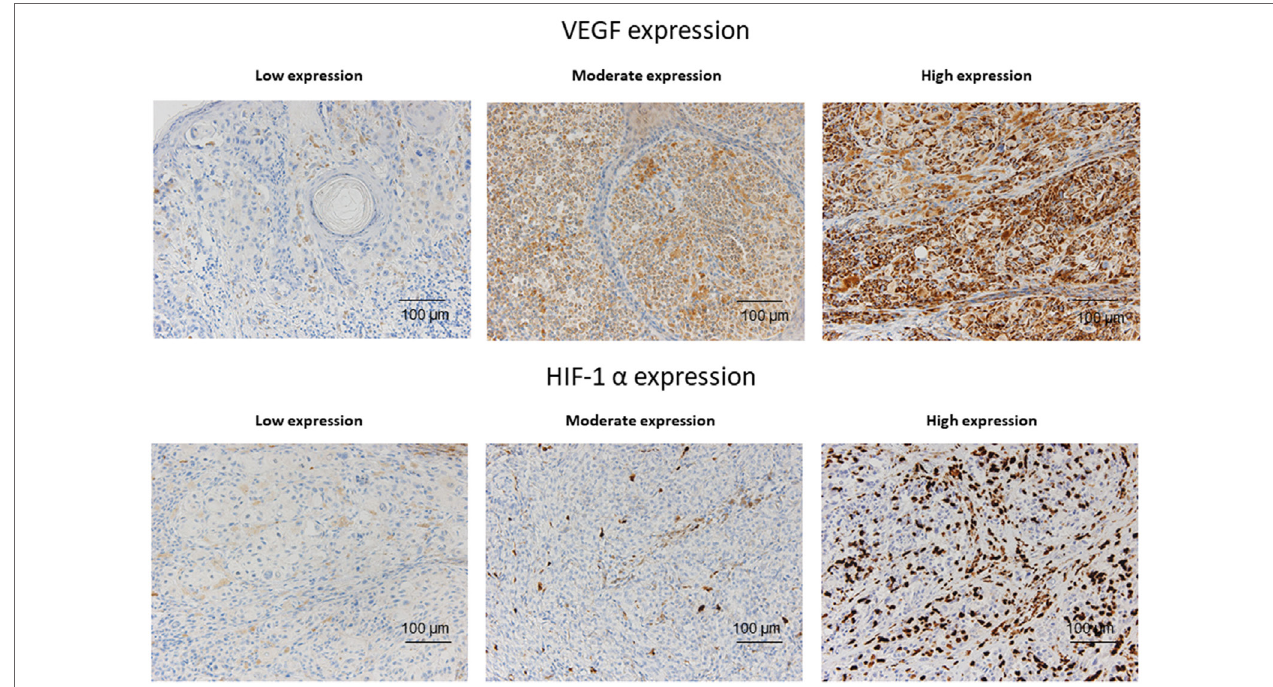
FigUre 1 | Representative examples of VEGF and HIF-1 α expression according to expression levels (low, medium, and high) in melanoma